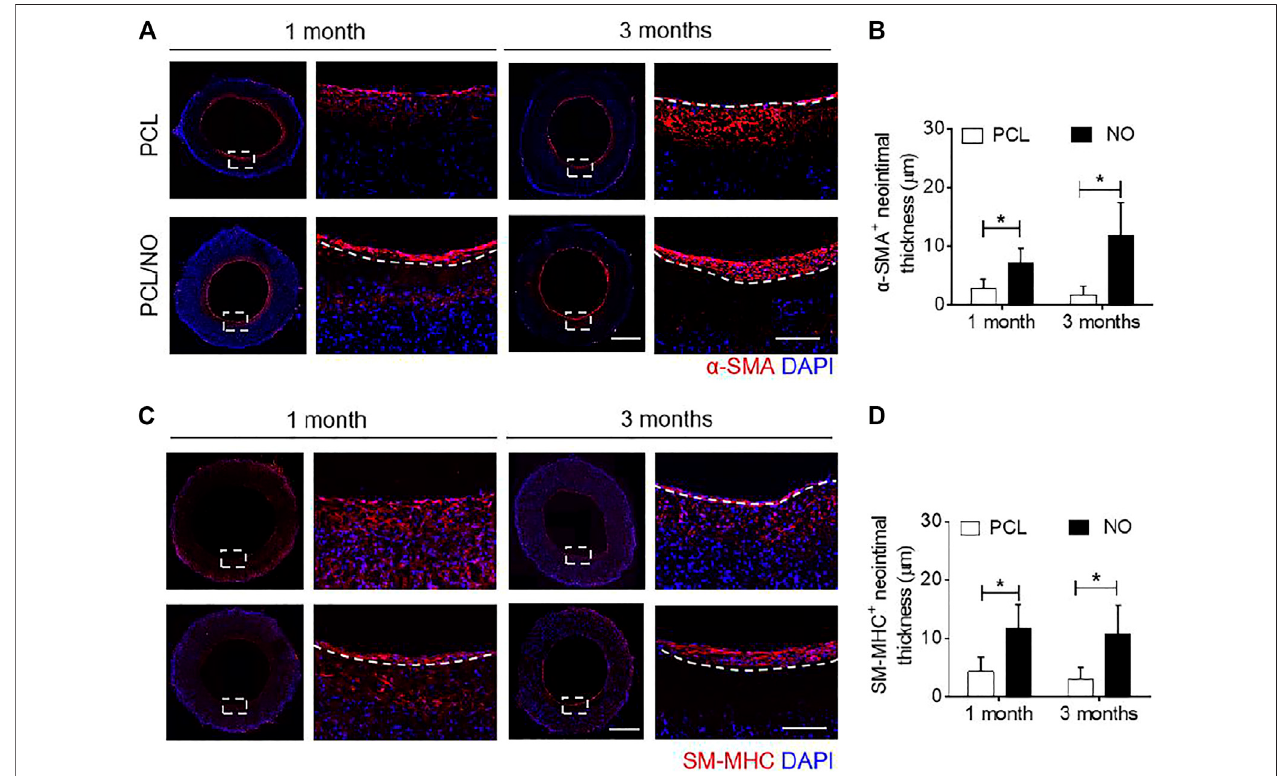
FIGURE 4 | Sustained NO release from nitrate-functionalized SDVGs enhances the formation of an organized VSMC layer. (A) Immunohistochemical staining of SDVGenfacesections( leftpanels ,scalebar (cid:1) 1 mm; rightpanels ,scalebar (cid:1) 100 µm)for α -SMAexpressionat1-and3-monthspost-implantation. (B) Quanti fi cation ofaverage α -SMA + neointimalthickness. (C) ImmunohistochemicalstainingofSDVGenfacesections( leftpanels ,scalebar (cid:1) 1 mm; rightpanels ,scalebar (cid:1) 100 µm) for SM-MHC expression at 1- and 3-months post-implantation. (D) Quanti fi cation of average SM-MHC + neointimal layer thickness. Images and data are representative of n (cid:1) 4 independent experiments. White dashed line boxes indicate zoomed area. White dashed line borders indicate the graft